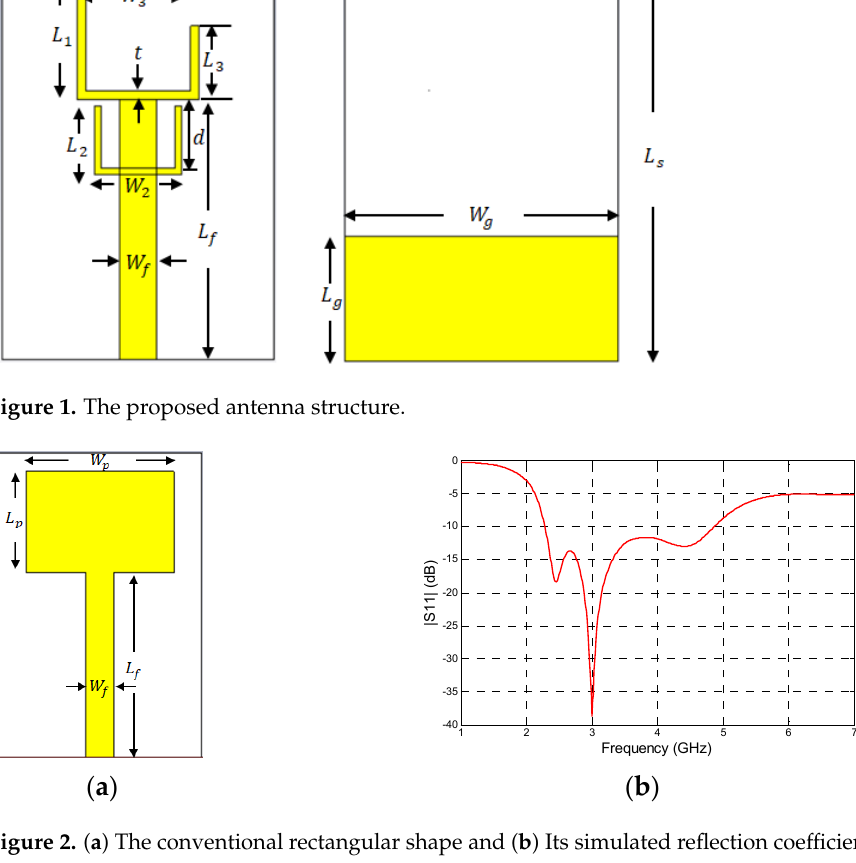
Figure 2. ( a ) The conventional rectangular shape and ( b ) Its simulated reflection coefficient